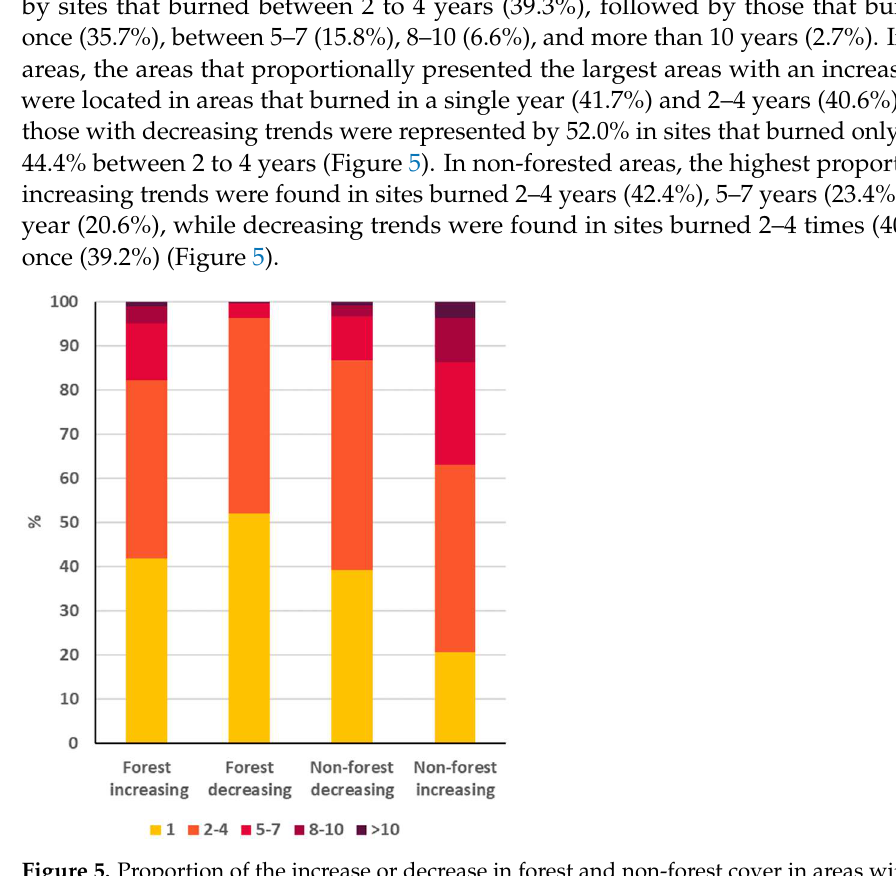
Figure 5. Proportion of the increase or decrease in forest and non-forest cover in areas with different ranges of annual forest fire recurrences in Bolivia (1, 2–4, 5–7, 8–10, and >10), according to the Mann-Kendall test and statistically significance values.